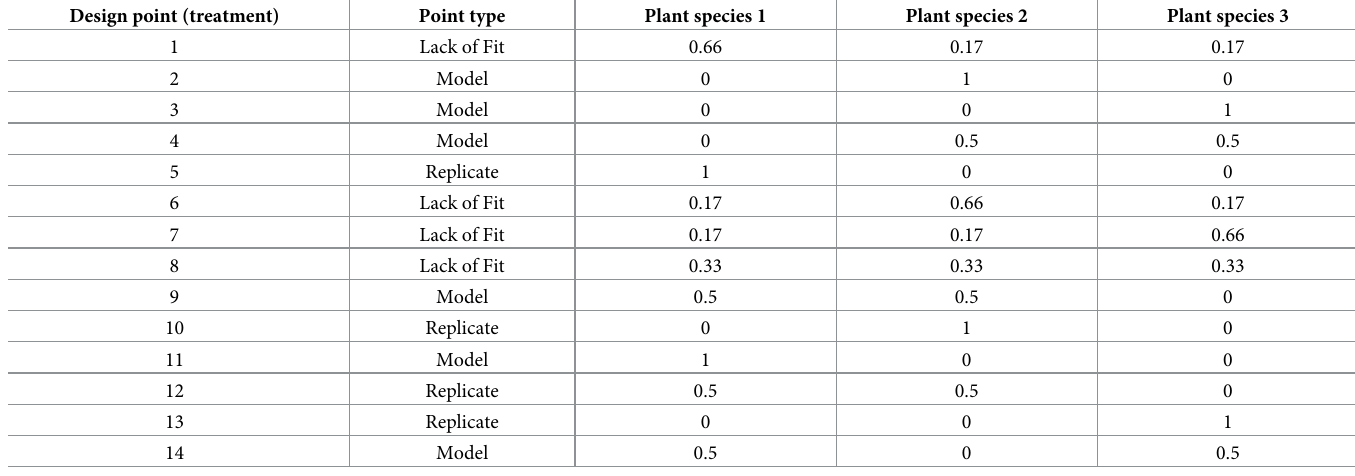
Table 2. Proportions of plant species in each treatment within the mixture design. Note that the ‘control’ treatment (0,0,0) is not included here because there is no null mixture in the design space; it was included in the experiments only as a reference. Design point